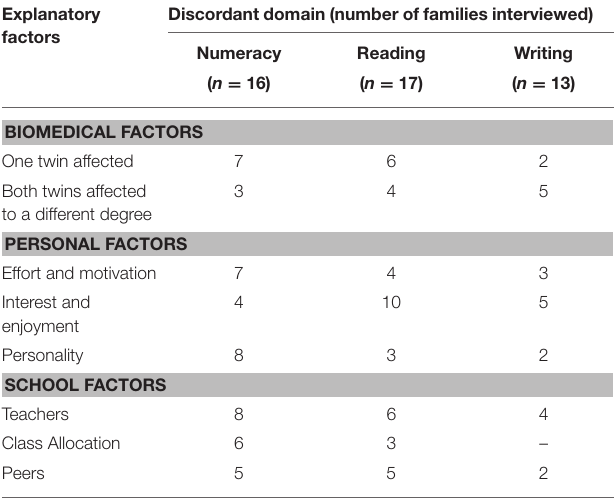
TABLE 3 | Explanatory Factors Identified by